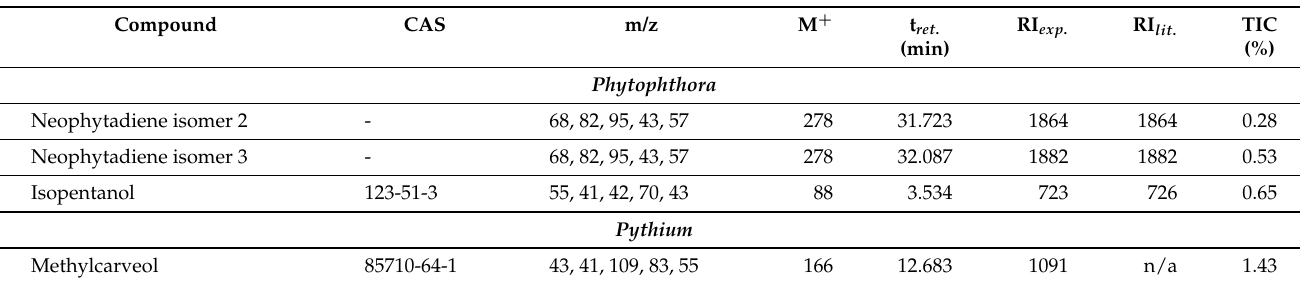
Table 2. The VOCs differentiating the measured samples of acorns infected by the Phytophthora and Pythium oomycetes, detected by the Gas Chromatography-Mass Spectrometry method. Meaning of the table columns is provided in Appendix A Table